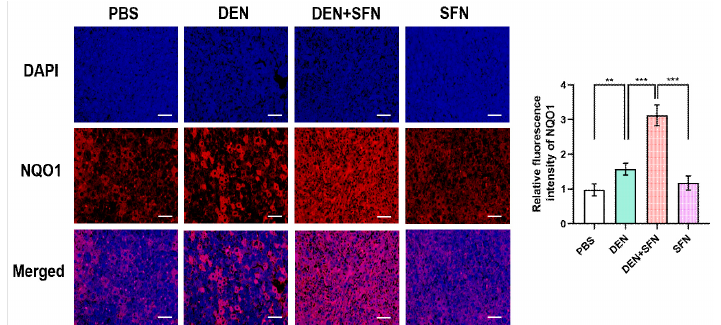
Figure 6. Immunofluorescence staining of NQO1 in the livers of control mice, DEN-treated mice with and without SFN administration, and mice treated with SFN alone. The paraffin sections of liver tissues were subjected to immunofluorescence staining with antibodies against NQO1 (red). DAPI (blue) was used to label cellular nuclei. Images were visualized under a fluorescence micro- scope. The fluorescent intensity was analyzed by the image processing program Image J and results are shown as the mean ± SD of 4 samples for each group. ** p < 0.01; *** p < 0.001. Representative images of stained sections are displayed. Scale bar, 100 μ m.